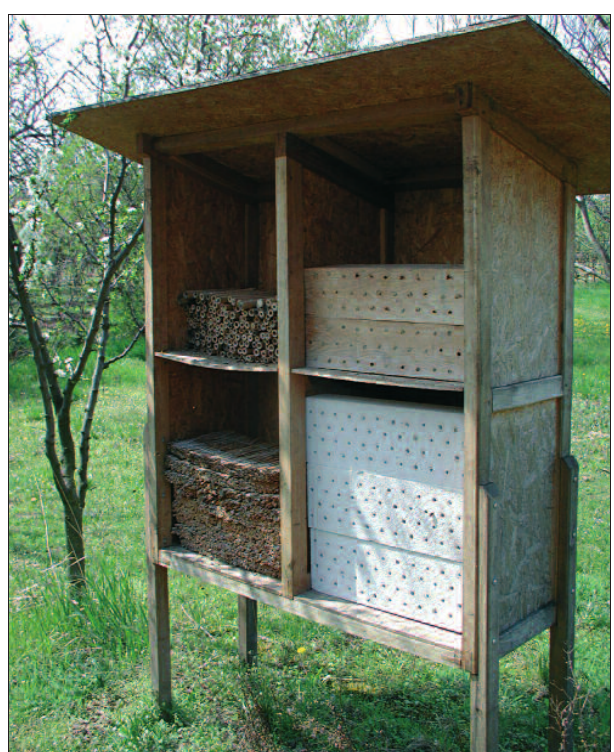
Figure1. Beeshelter(“wildbeehive”)withartificialnestingmediafor Osmia